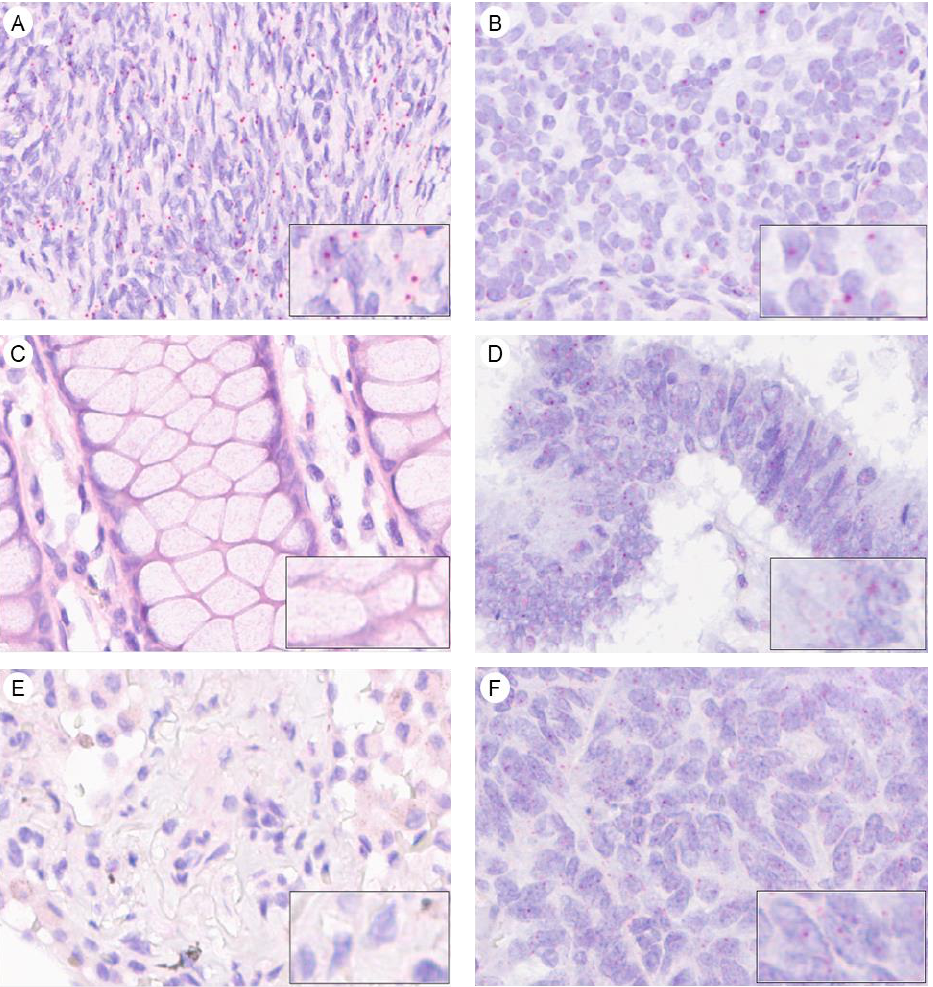
Figure 2. RNA in situ hybridization for semi-quantitative determination of mRNA expression levels of AMHRII in normal human tissues ( A , C , E ) and tumoral human tissues ( B , D , F ). Normal and tumoral tissues were stained with specific RNA AMHRII probes Hs-AMHRII (30ZZ). ( A ) Normal ovary tissue, RNAscope score 1, ( B ) Ovarian cancer, RNAscope score 1, ( C ) Normal colon, RNAscope score 0, ( D ) Colon cancer, RNAscope score 1, ( E ) Normal lung, RNAscope score 0, ( F ) Lung cancer, RNAscope score 1. Scoring was determined according to the manufacturer criteria: Score 0, no staining or less than 1 dot/10 cells; score 1, 1–3 dot/cell; score 2, 4–9 dots/cell; score 3, 10–15dots/cell; score 4 more than 15